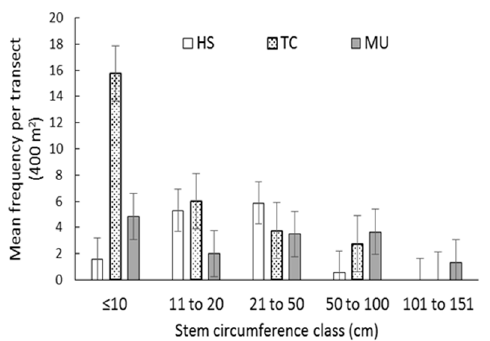
Figure 7. Stem-circumference size distribution at three study sites. TC site had relatively more saplings compared to HS and MU, indicating that it is undergoing vigorous recruitment.